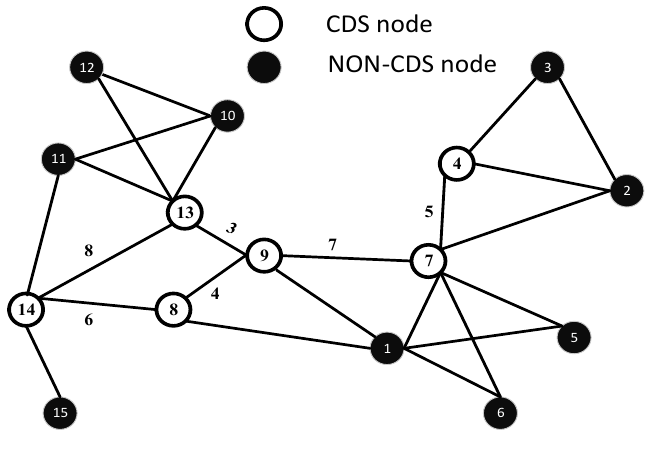
Figure 2. Formation of the